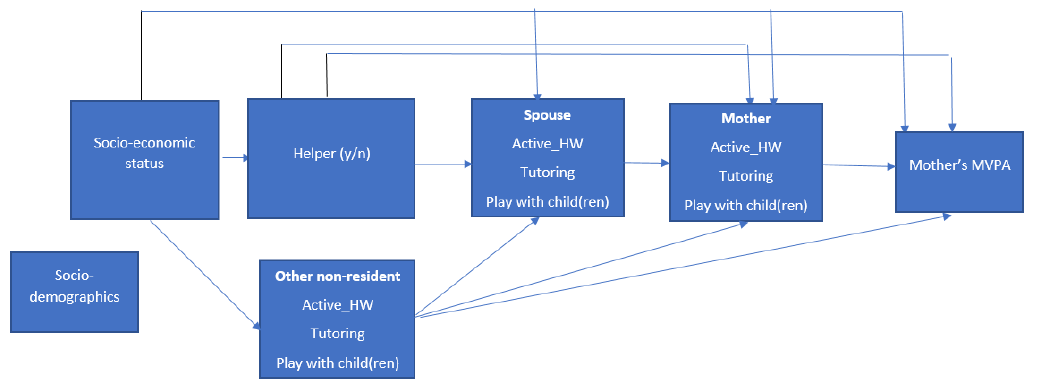
Figure 1. Conceptual model of socioeconomic status, household composition, activities, and their associations with the mother’s moderate to vigorous physical activity (MVPA) .